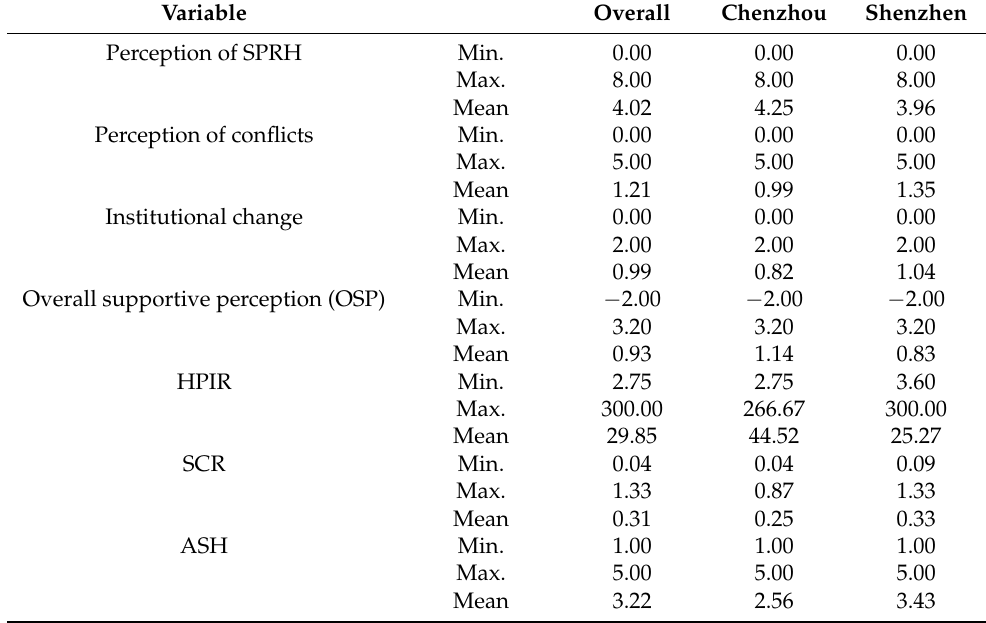
Table 3. Descriptive statistics of actors’ overall supportive perceptions of SPRH and the independent